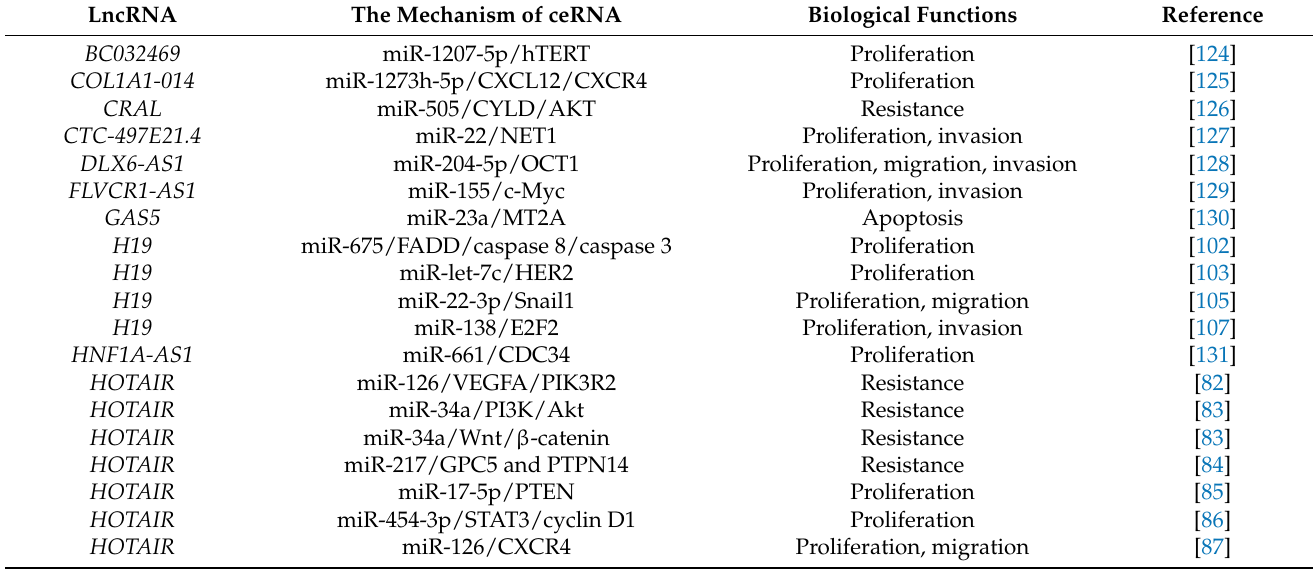
Figure 1. Representative lncRNA-mediated ceRNETs in GC. Table 2. The mechanism of lncRNAs as ceRNAs in